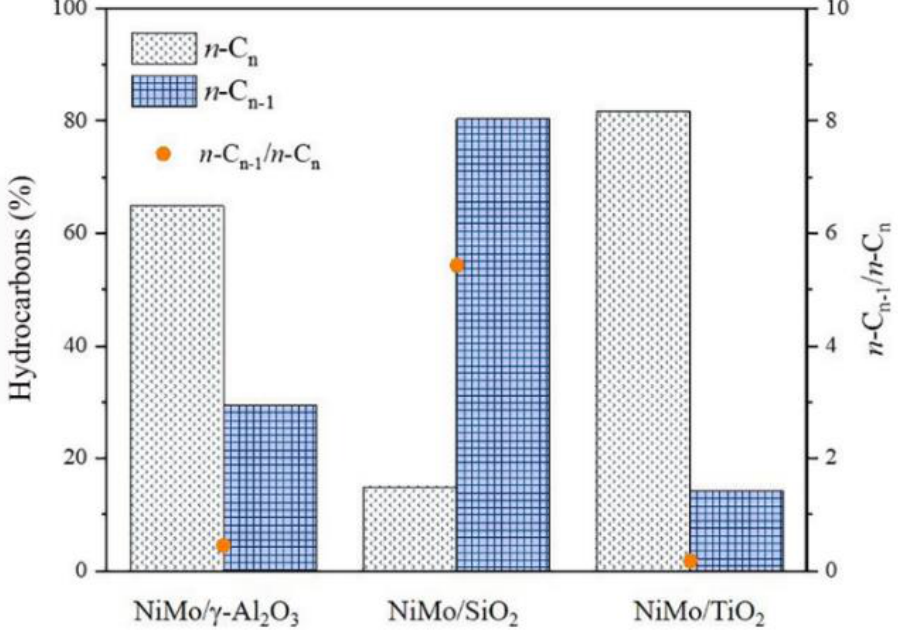
Figure 6. Effect of catalyst on n -C n-1 and n -C n in diesel range of NiMo/ γ -Al 2 O 3 , NiMo/SiO 2 , and NiMo/TiO 2 catalysts. All experiments were conducted at a temperature of 330 °C, H 2 pressure of 50 bar, WHSV = 1.5 h −1 , and H 2 /oil ratio = 1000 cm 3 /cm 3 .